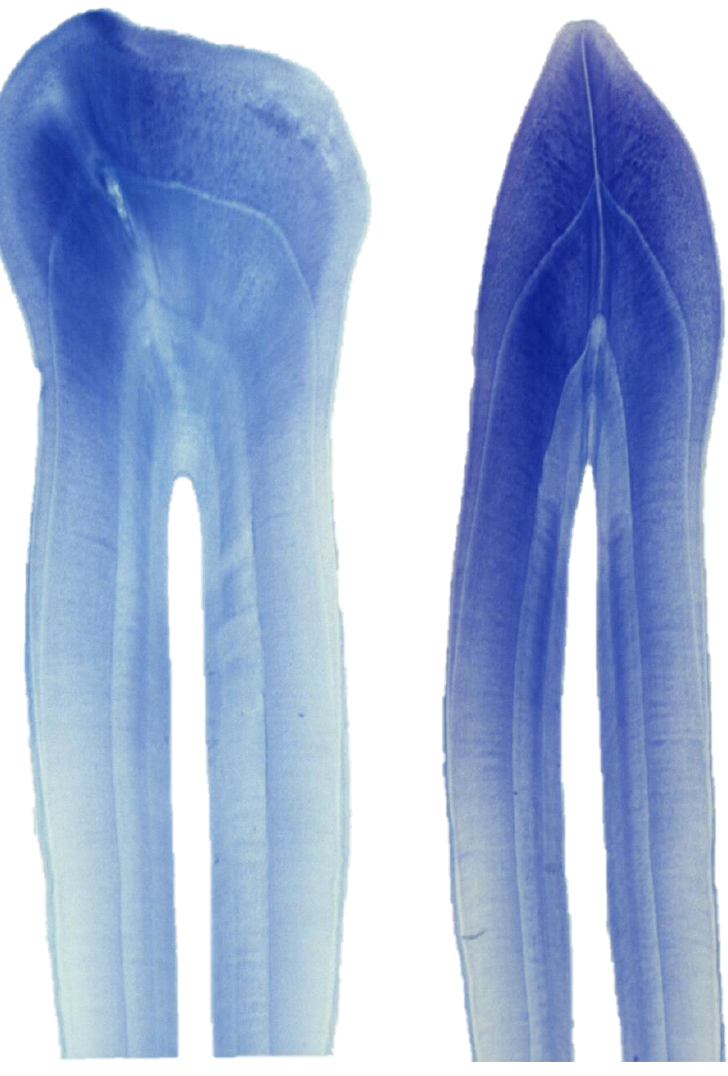
Fig. 6. Harbour porpoise ( Phocoena phocoena ) teeth from the same animal cut at two planes; sagittal plane (left) and buccal-lingual plane (right). Various stains have also been tested. Luque et al . (2009a) tested four stains previously reported in the literature and recommended Mayer’s haematoxylin overall. A commonly used modification of Mayer’s haematoxylin that eliminates the need for aging of the stain is provided in Myrick et al . (1983). Lockyer et al . (2010) reported that GLGs in the cementum of harbour seal tooth sections are more prominent with Toluidine Blue while